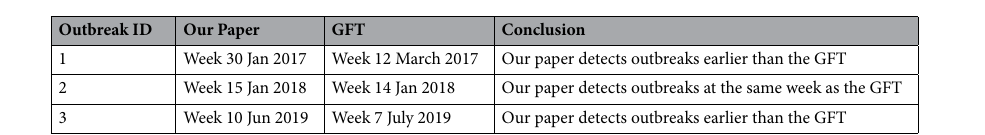
Figure 8. Outbreak detection result vs GFT for the southern region.